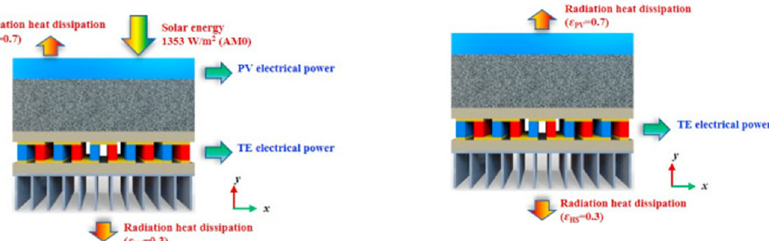
Figure 3. The schematic of the PV-MFCPCM-TE physical model [11]. Reproduced with permission from Elsevier.